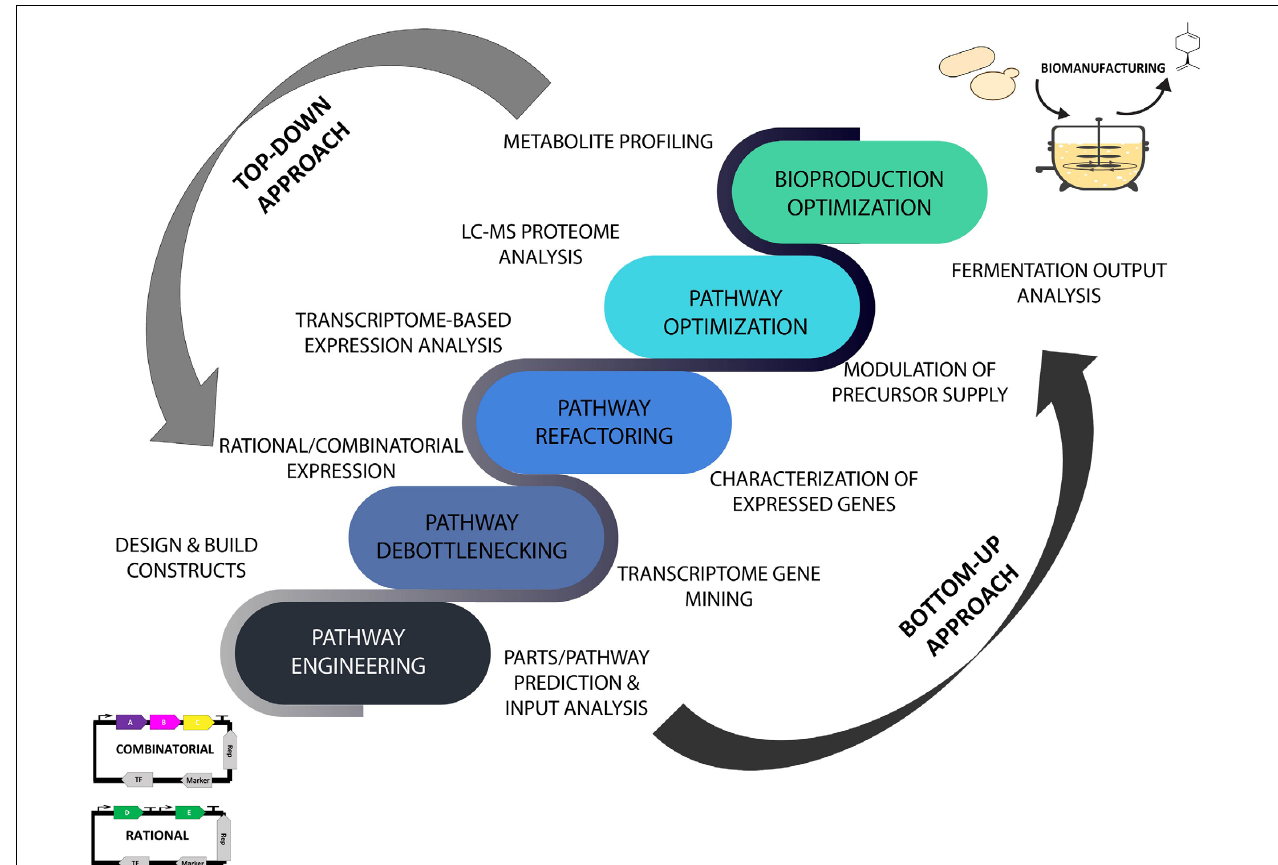
FIGURE 1 | Top-down and bottom-up biomanufacturing strategies driven by omics and machine learning tools using high throughput analytical and predictive engineering technologies. Top-down approach focused on strain optimization and bioproduction improvement. Bottom-up approach aimed at reconstruction and refactoring of biosynthetic pathways for synthesis of existing and new-to-nature bioproducts. LC-MS, liquid chromatography–mass